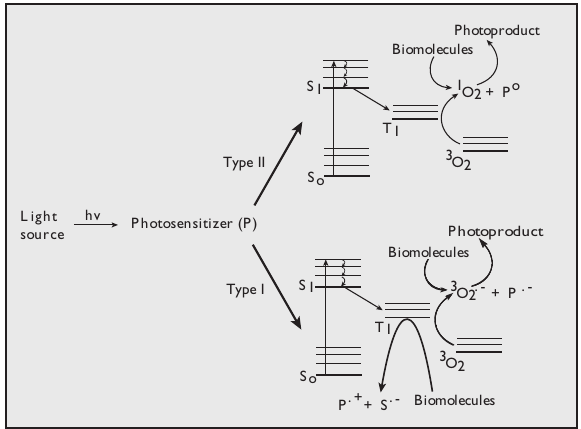
Figure 3 – Mechanisms (types I and II) of ROS generation by combination of light, photosensitizer (P), and ground-state oxygen ( 3 O (S ) is irradiated with visible light generating excited singlet state photosensitizer (S 0 S